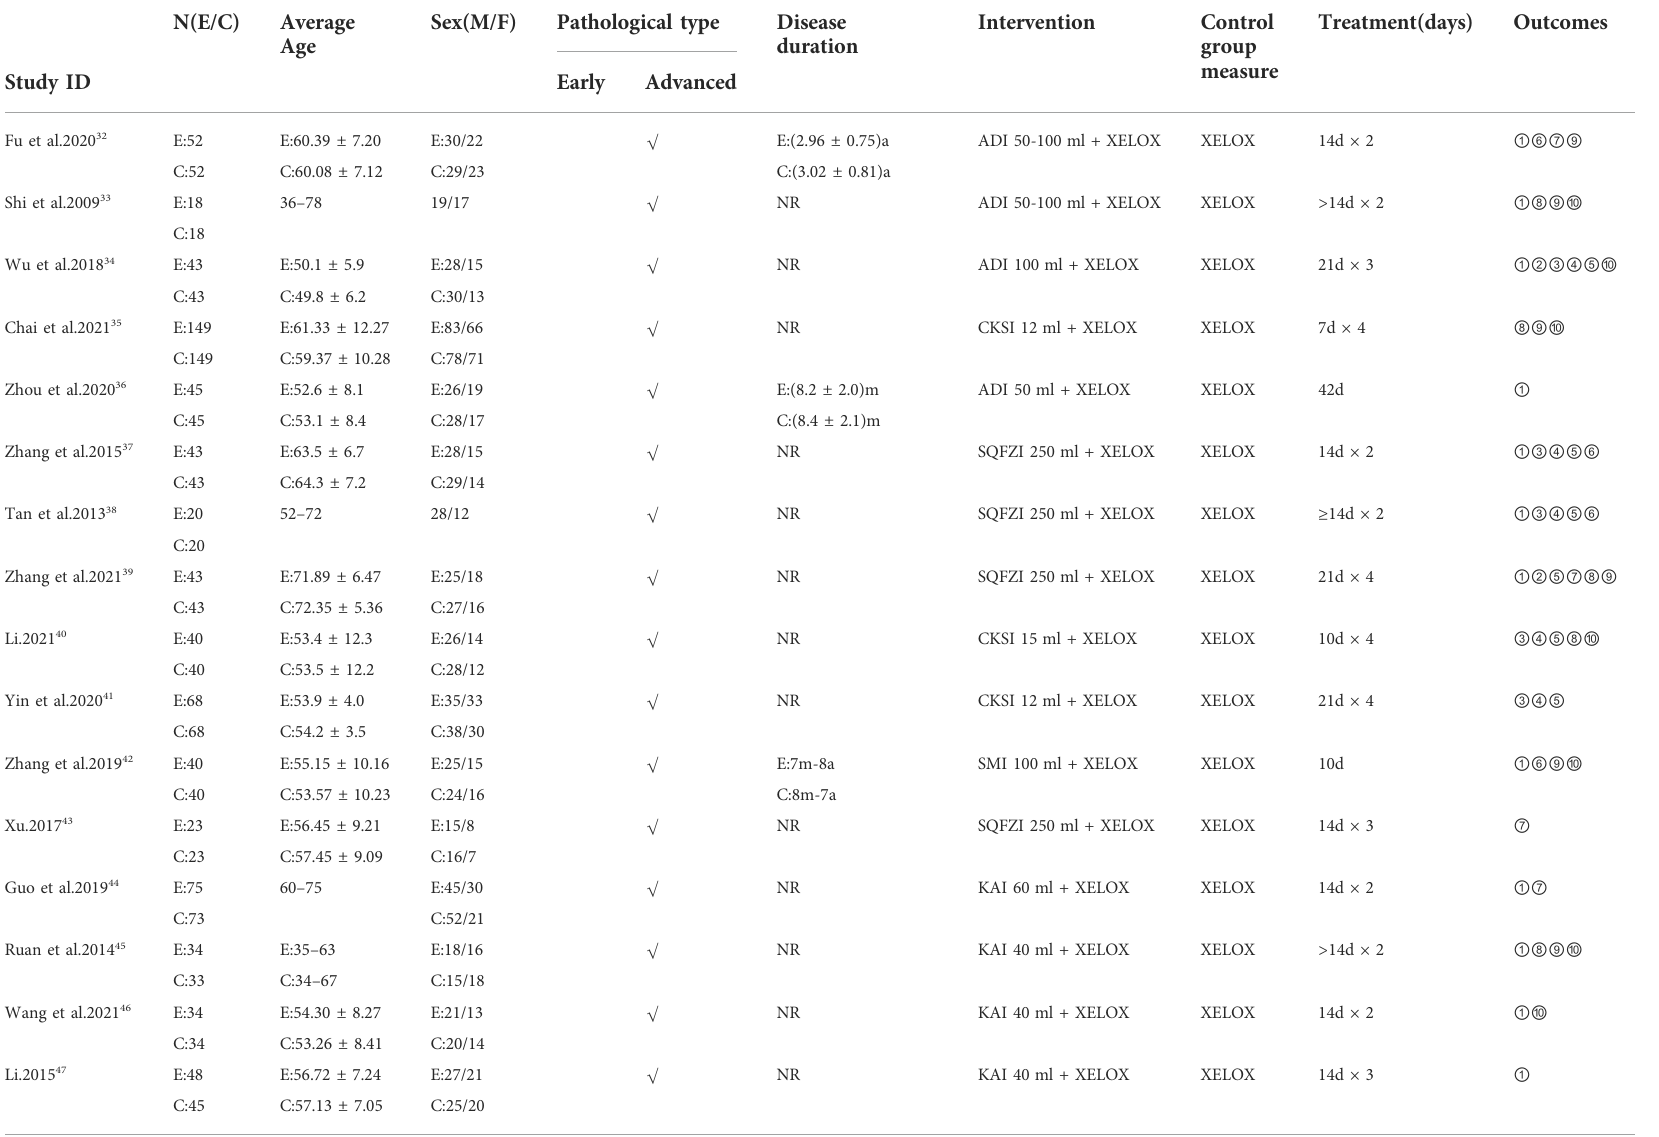
TABLE 1 The basic characteristics of the included